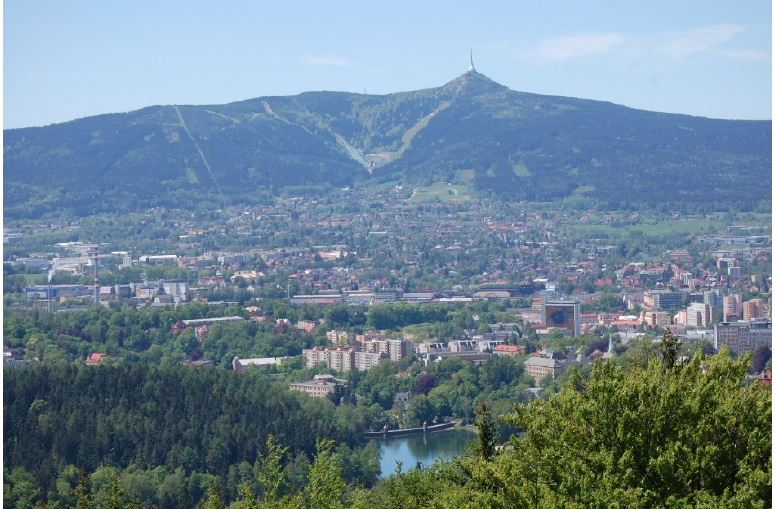
Figure 4. Liberec, P ř ehrada Harcov in the foreground and the landmark mountain Ješt ě d in the background (photo: K. Hrbková).